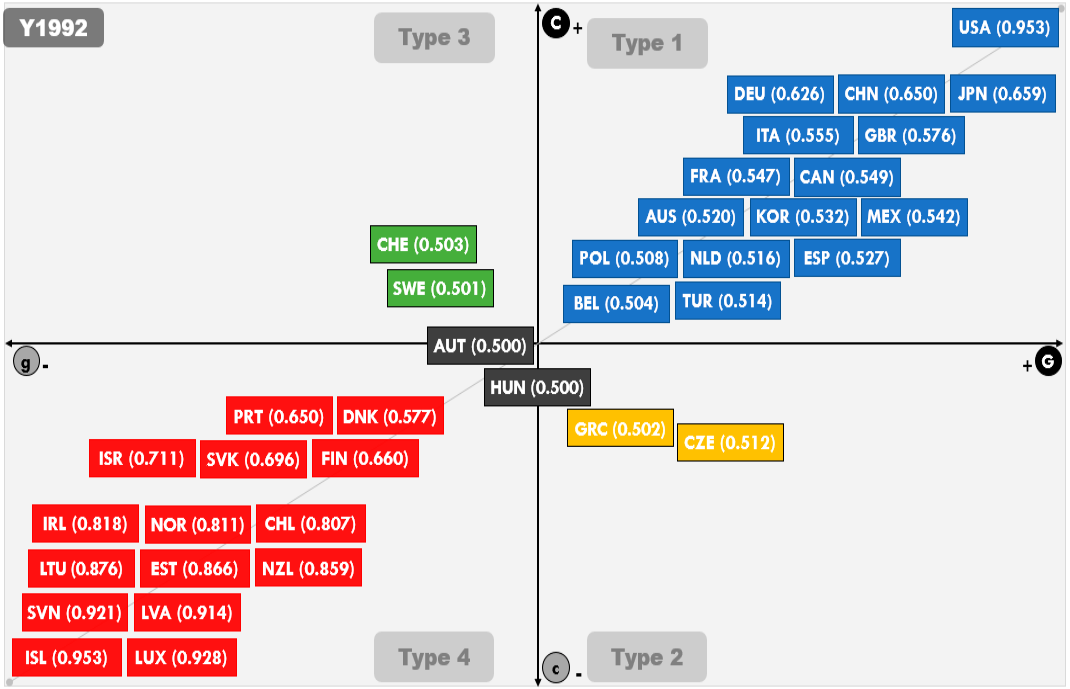
Figure 1. The Location of Link Types of the 37 Case Countries in 1992.